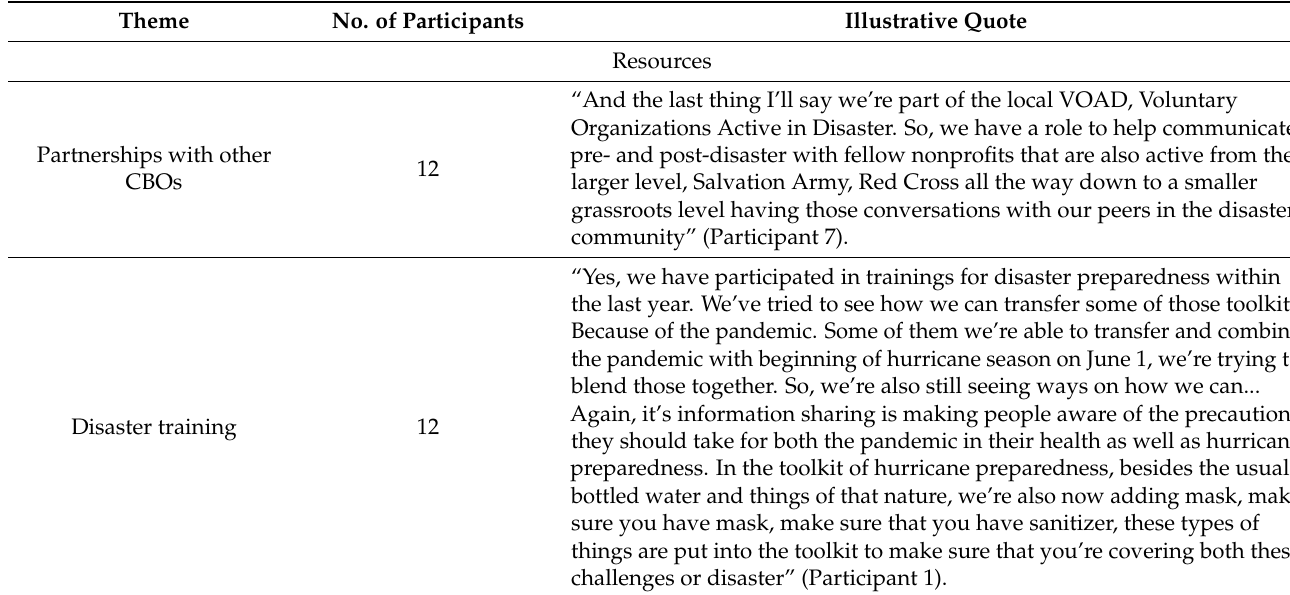
Table 4. Themes and illustrative quotes relating to impact of disaster preparedness and response on response to the COVID-19